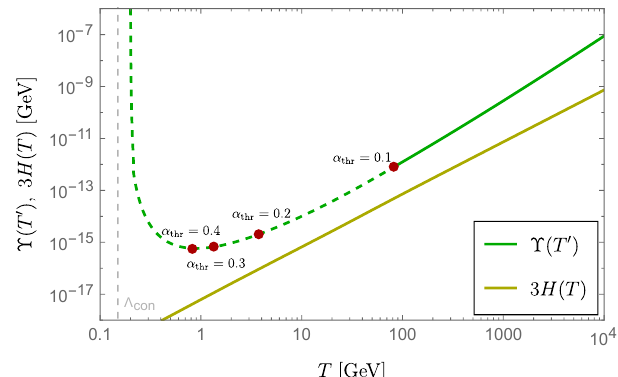
Figure 4 . Gauge friction versus Hubble friction for some example parameter values. The red dots denote the instant we switch off the friction effects depending on the largest acceptable value of the gauge coupling α thr